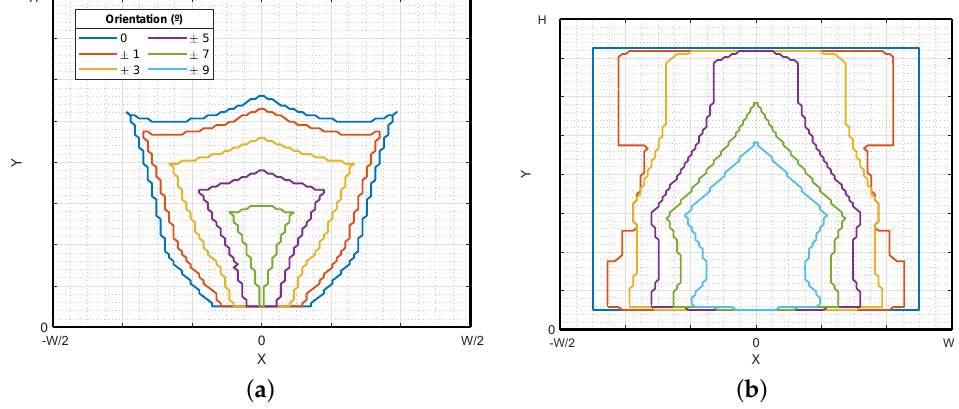
Figure 3. Workspace comparison. ( a ) Conventional scheme; ( b ) new